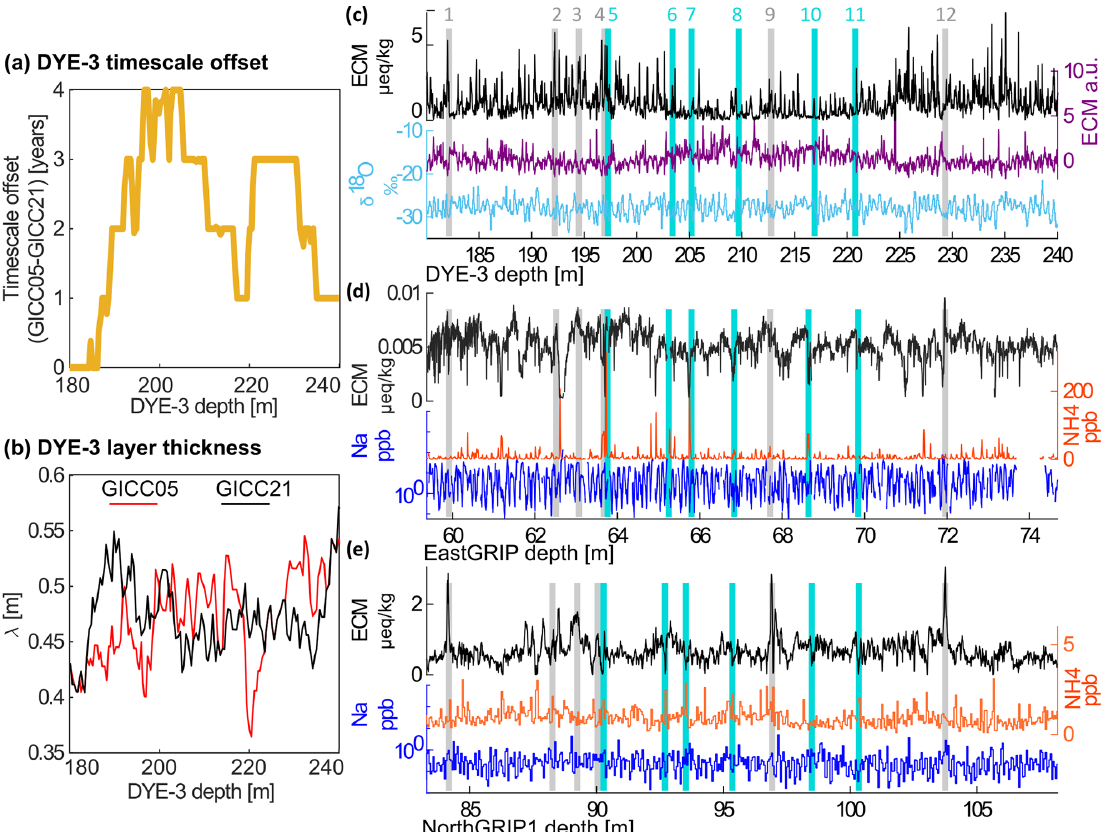
Figure 5. (a) The first divergence of the timescale offset, at 390–490b2k, reported on the DYE-3 depth scale. Four layers were removed between 190 and 200m, but they were gradually added back in the earlier part of the timescale. (b) The layer thickness in this interval presents a fluctuation towards thicker layers, possibly because of upstream flow effects (Vinther et al., 2006). Between 180 and 240m, the layer thickness according to GICC05 presents a more gradual increase than according to GICC21 but in turn has a sharp dip at 220m, which is not present in the GICC21 layer count. (c–e) By looking at the actual data, it becomes clear that DYE-3 is very hard to match in this depth range. The fact that the stratigraphy of DYE-3 has been lightly disturbed could have affected the signals, so that both the ECM dips and peaks become almost unrecognizable. The layers present many irregularities that make the fine-tuning more uncertain than usual. (d) For EastGRIP, we observed that the broad shape of tie point no. 9 caused the match to be revised and placed 2 years later than what was done by Mojtabavi et al.